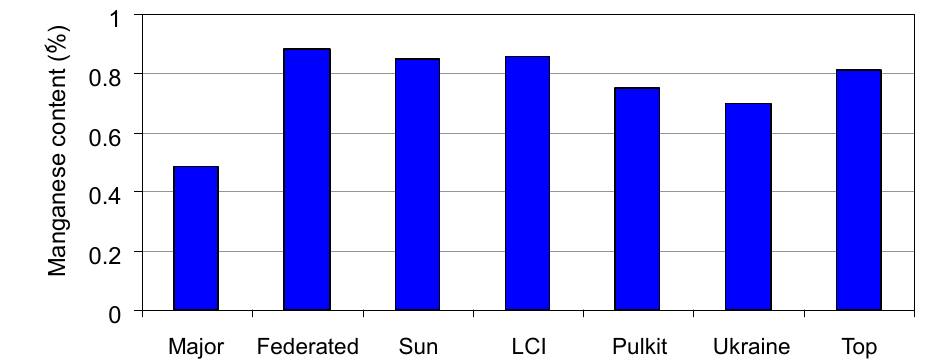
Fig. 2. Silicon(Si) contents in steel specimens.